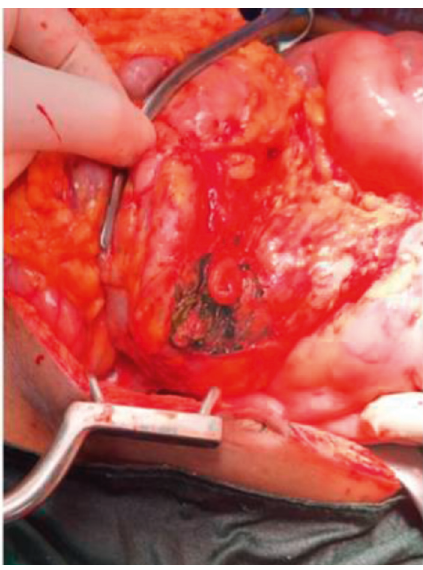
Figure 4: Areas of perforation on the proximal ascending